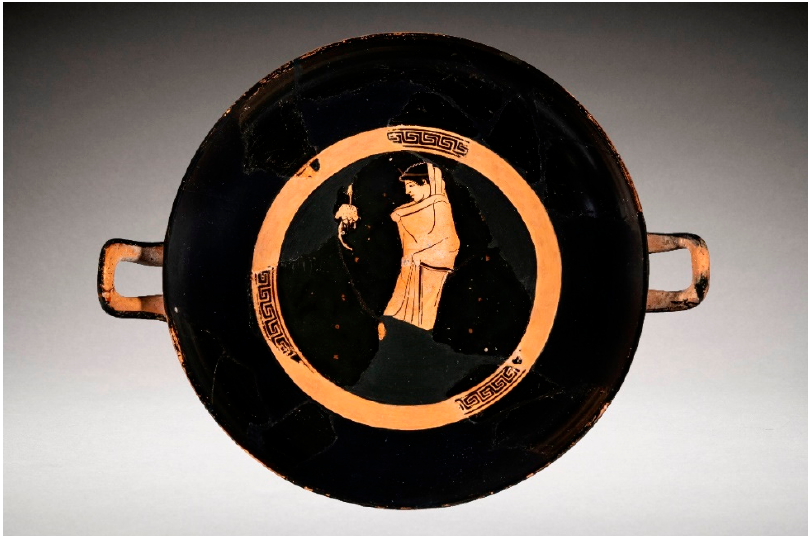
Figure 1. Interior of a kylix attributed to the Antiphon Painter. Baltimore, Johns Hopkins Archaeological Museum B11. Photo courtesy the Johns Hopkins Archaeological Museum. Used by permission. 490–80 BCE.